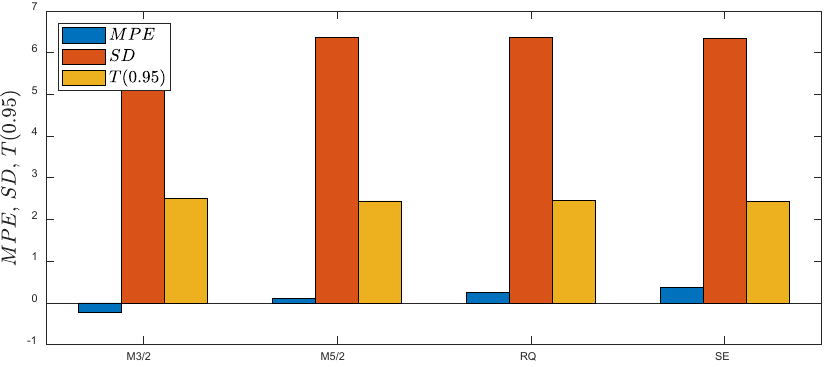
Figure 9. Comparison of error indexes obtained by the application of different kernels to the fatigue GP-based model trained using the second dataset.